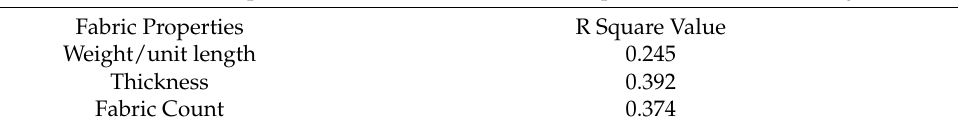
Table 5 . Statistical analysis of single layer fabric system in presence of moisture .